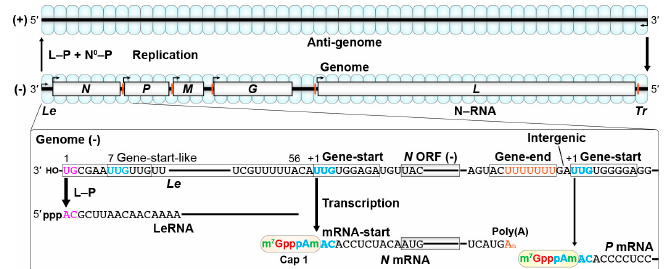
Figure 1. Transcription and replication of the rabies virus (RABV) genome. The negative-strand RABV genome wrapped with the nucleocapsid (N) proteins serves as a template for transcription (lower) and replication (upper). The RNA-dependent RNA polymerase (RdRp, the complex between large (L) and phospho- (P) proteins) sequentially transcribes the leader region ( Le ) and five internal genes ( N , P , M , G , and L ) in the genome into the leader RNA (LeRNA) and five monocistronic mRNAs with the 5 (cid:48) -cap 1 and 3 (cid:48) -poly(A) structures by the stop-start transcription mechanism. The RdRp carries out encapsidation-coupled genome replication together with the complex of the RNA-free N protein with the P protein (N 0 -P). Partial RNA sequences of the genome and transcripts of RABV (PV strain, GenBank id: M13215) are shown. The conserved gene-start and gene-end sequences serve as transcription initiation and polyadenylation / termination signals, respectively. The conserved mRNA-start sequence acts as an mRNA capping signal. HO- and ppp indicate hydroxyl and triphosphate groups, respectively. m 7 GpppAm indicates N 7 -methylguanosine(5 (cid:48) )triphospho(5 (cid:48) )2 (cid:48) - O -methyladenosine (cap